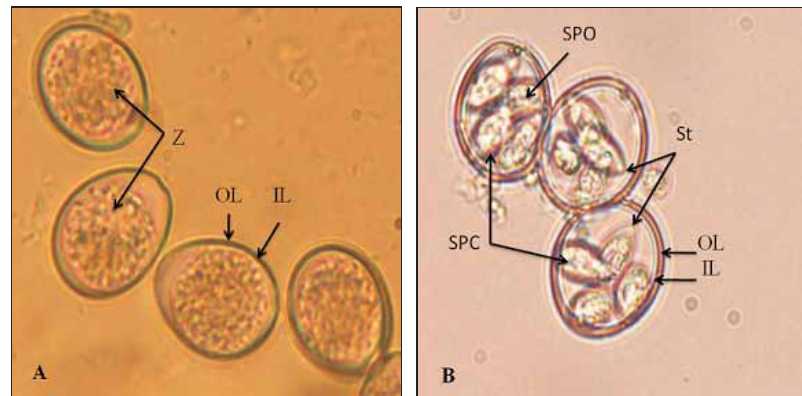
Figure-1: (A) Oocysts morphological feature: Photomicrograph of freshly shed unsporulated oocyst (Z-zygote); in the ovoidal was shown. Two layers of the oocyst wall (OL-outward, IL-inward). x 400.;